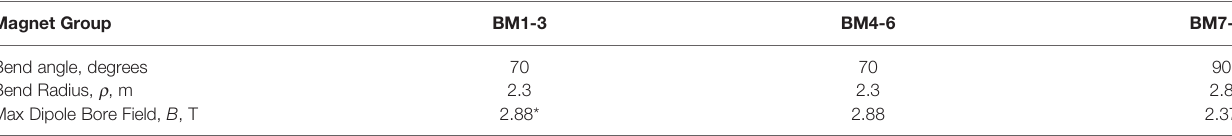
*Magnetic rigidity of 430 MeV/u carbon ions, M = 6.627 Tm ( Appendix A2 ) hence B = M/ r =2.88 T.